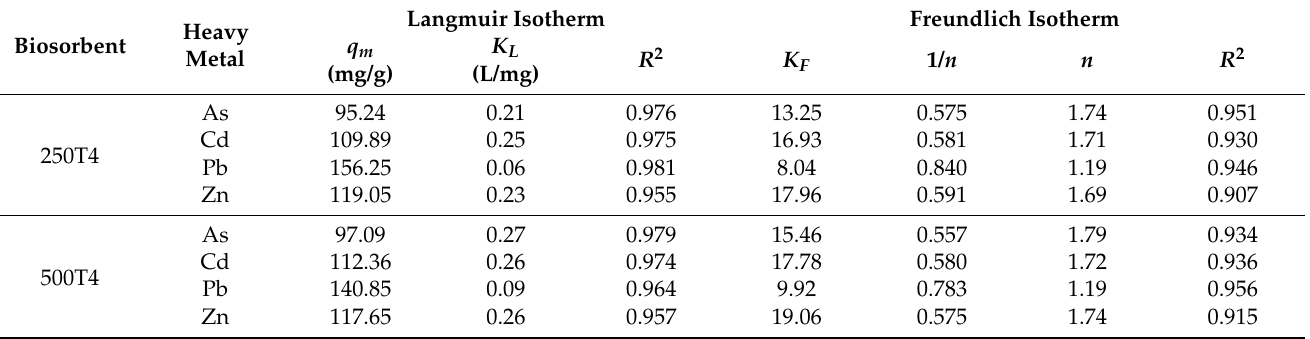
Table 4. Parameters of the adsorption isotherms for the T4 biosorbent (250 and 500 µm fractions).